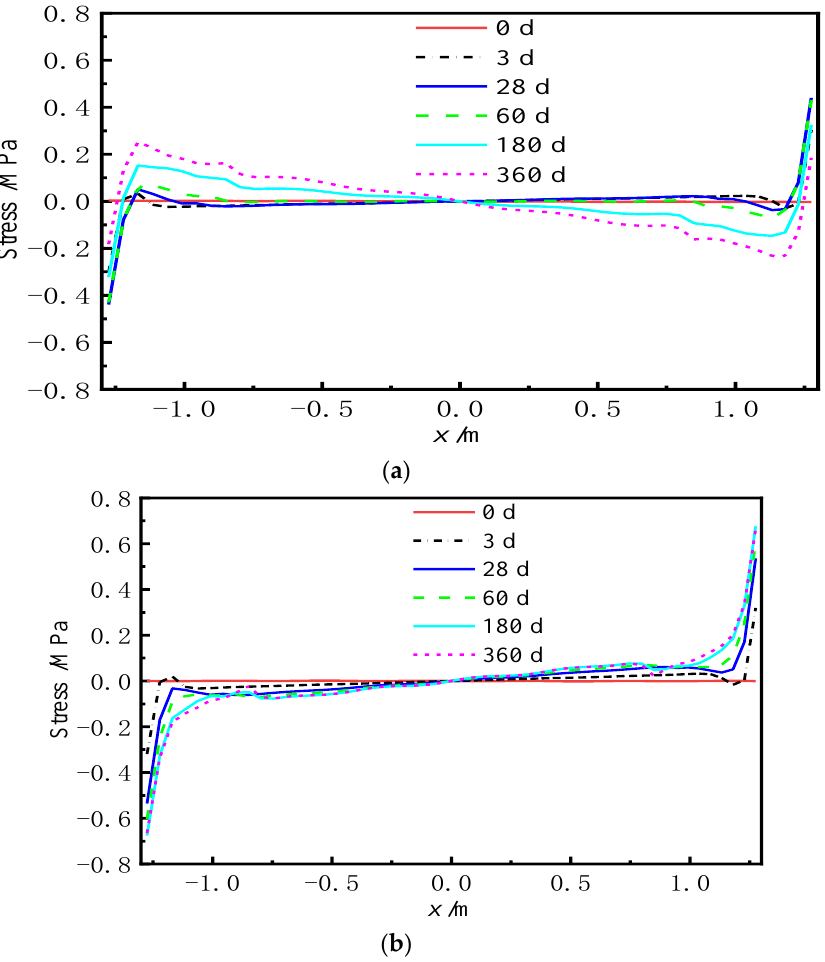
Figure 20. Interfacial stress with the shear cogging. ( a ) AOTSL of 60 d. ( b ) AOTSL of 360 d. It can be seen from Figure 22 that the interfacial stress at the slab edge increases sharply at first and then decreases gradually with time. In addition, the interfacial stress increases with the increase in AOTSL. Moreover, the time of the peak stress appearance increases gradually with the increase in AOTSL. At the AOTSL of 60 d, the interfacial stress reaches the peak value of 0.440 MPa at 28 d with and without the shear cogging. When the AOTSL is 360 d, the interfacial stress reaches the peak value at 180 d, which is 0.676 MPa and 0.642 MPa for the cases of with and without the shear cogging effects, respectively, reaching 70.7% and 67.2% of the interfacial shear strength. Thus, it can be concluded that the effect of the shear cogging on interfacial stress can be ignored. Furthermore, to reduce the additional interface stress caused by the shrinkage and creep effects of the ballastless track, the track slab should be laid as soon as